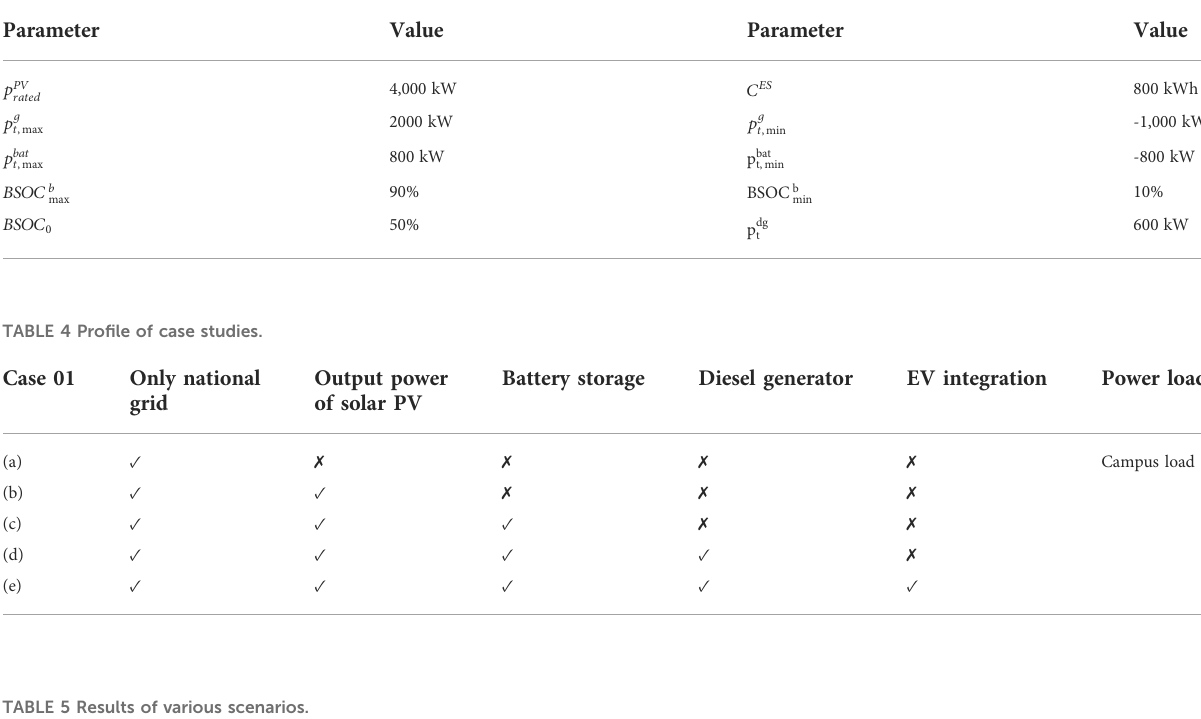
TABLE 5 Results of various scenarios. Scenario Only national grid